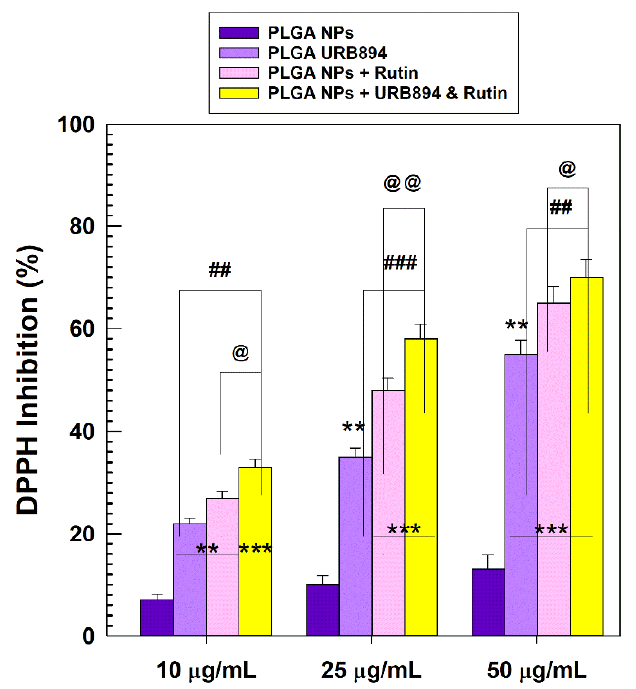
Figure 7. Antioxidant features of PLGA nanoparticles encapsulating URB894 (400 µg/mL) and rutin (600 µg/mL) as single agents or as a multidrug formulation evaluated by the DPPH assay. ** p < 0.001 and *** p < 0.0001 vs. empty PLGA nanoparticles. @ p < 0.05 and @@ p < 0.001 PLGA NPs + URB894 and Rutin vs. PLGA NPs + Rutin; ## p < 0.01 and ### p <0.0001 PLGA NPs + URB894 and Rutin vs. PLGA NPs + URB894. Results are the average of three independent experiments ± standard deviation. The concentrations of the active compounds tested as a multidrug formulation are the following: 50 µg/mL URB894 and 45.76 µg/mL Rutin; 25 µg/mL URB894 and 22.88 µg/mL Rutin; 10 µg/mL URB894 and 9.15 µg/mL Rutin.